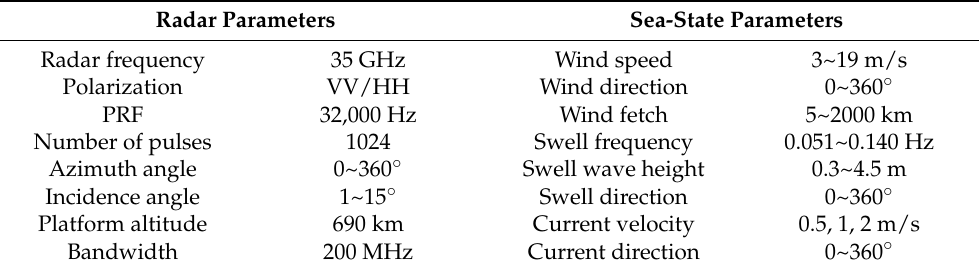
Table 1. Basic simulation parameters.